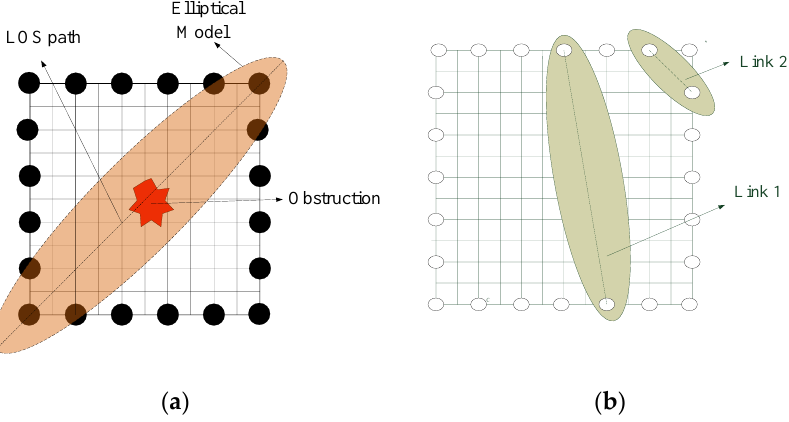
Figure 3. The elliptical weight model. ( a ) The longest link; ( b ) different links.